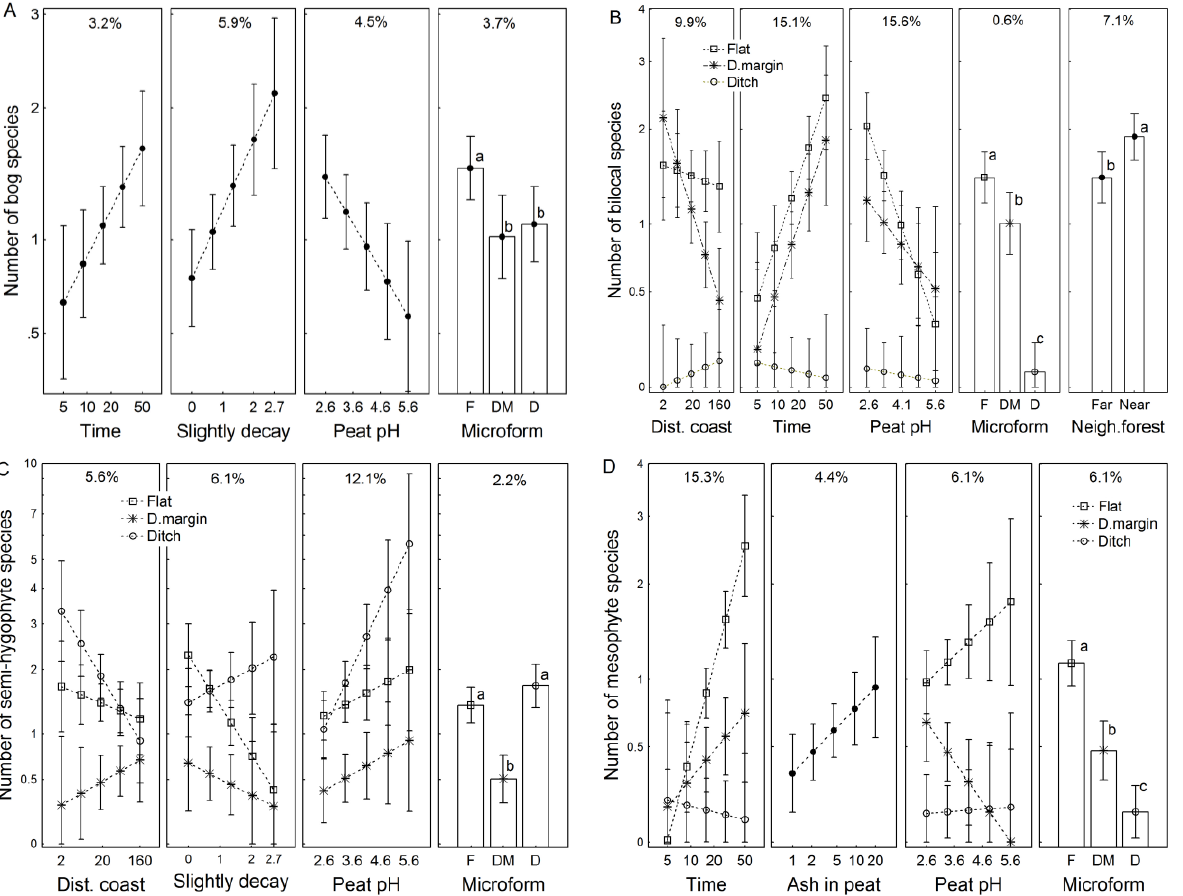
Figure 2. General linear model (GLM) predictions of species richness for four functional groups: A) bog species (raised bogs and transitional mires); B) acidophilous bilocals (raised bogs and heaths); C) semi- hygrophytes (early successional bogs including fens, swamps and some drier habitats); and D) mesophytes (mineral soils). Accompanying statistics are given in Table 2. Percentages at the top of each graph denote the variability accounted by each indictor factor in the GLM models. Time = log-transformed time (years) since peatland abandonment; Slightly decayed = thickness of slightly decomposed peat (m); Peat pH = pH of the upper-layer peat (0–0.5 m); Microform = microtopographical form type; Dist. coast = distance from the sea (log-transformed, km); Ash in peat = the log-transformed ash content of upper-layer peat (0–0.5